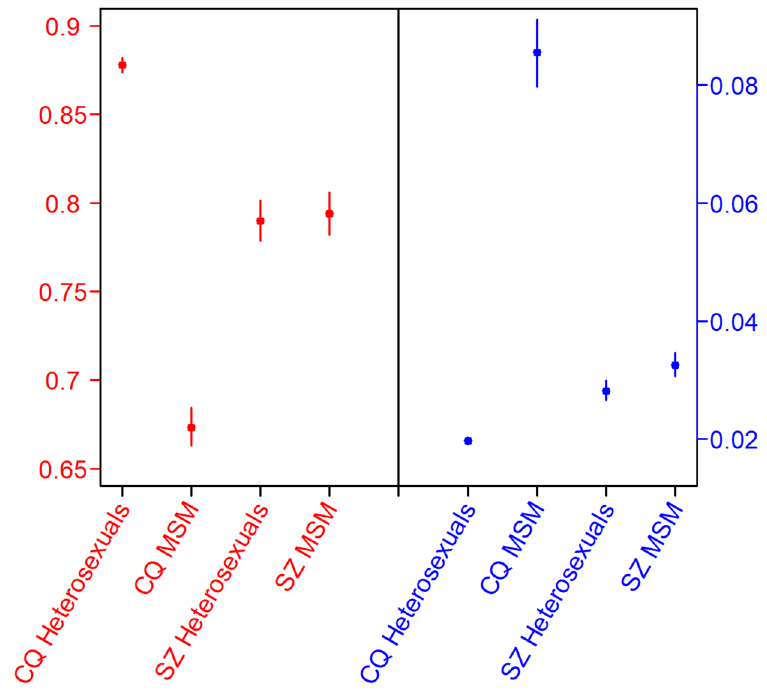
Fig 3. Parameter estimates and their corresponding 95% CI for each population in Chongqing(CQ) and Shenzhen (SZ).